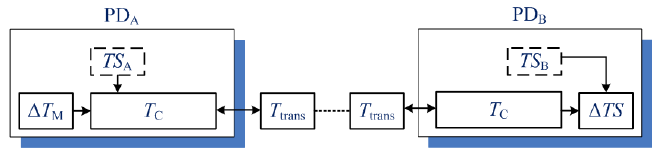
Figure 4. The communication process of the LCDP.